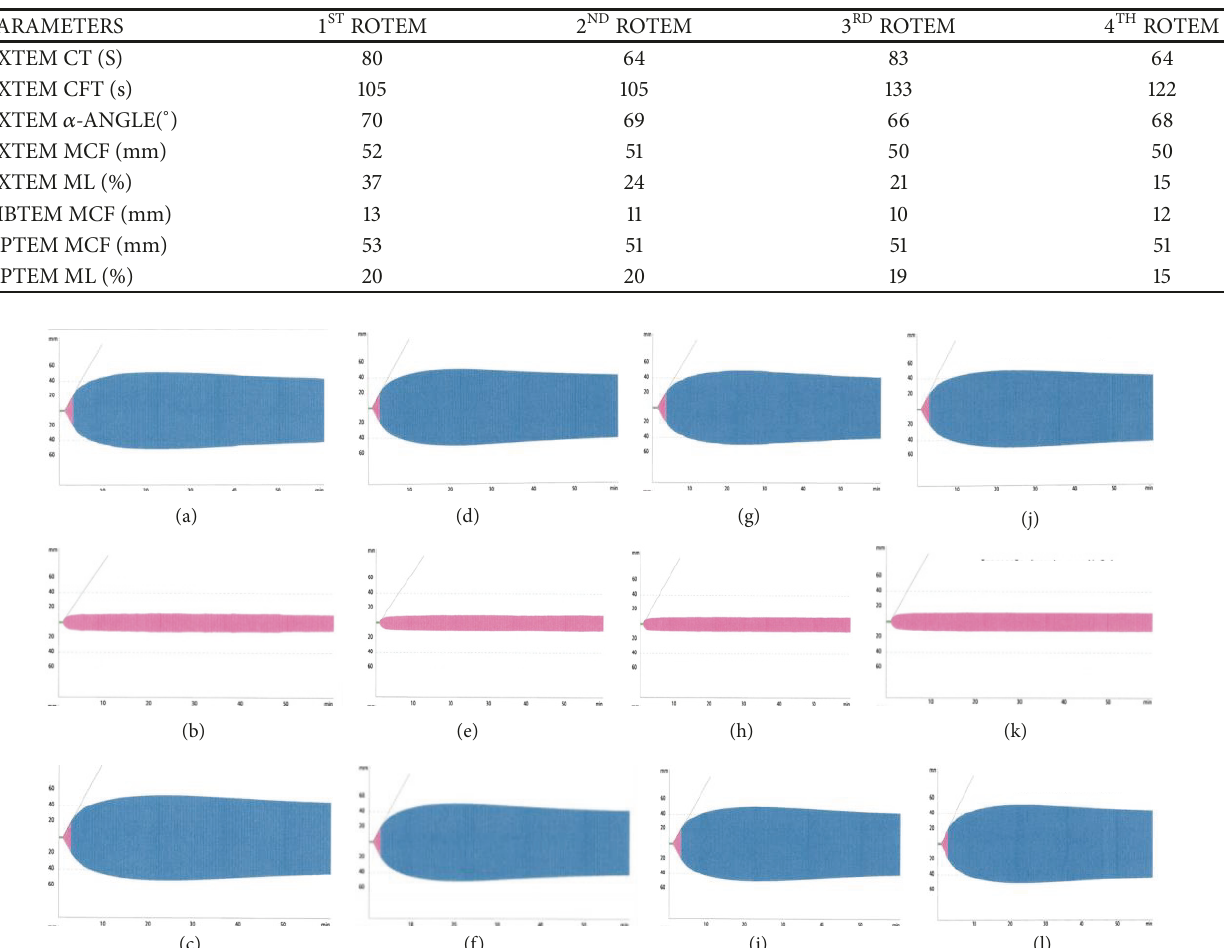
Table 1: Sequential analysis of thromboelastometry (ROTEM (cid:2) ) parameters.